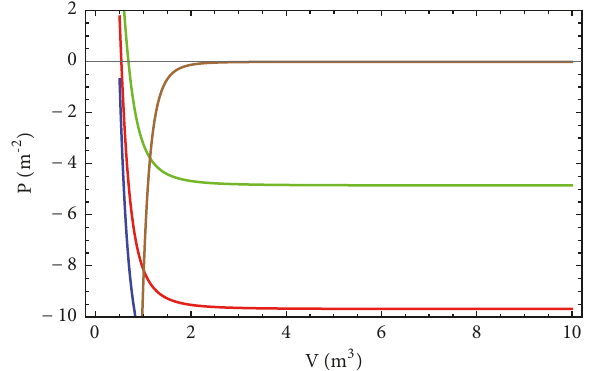
Figure 1: Plots of 𝑃 versus 𝑉 for 𝐴 = 2,𝛾 = −2,𝛼 = 0.1, 𝑑 = 1 with 𝑍 = 0.01 (brown), −5 (green), −7 (red), and −8 (blue).